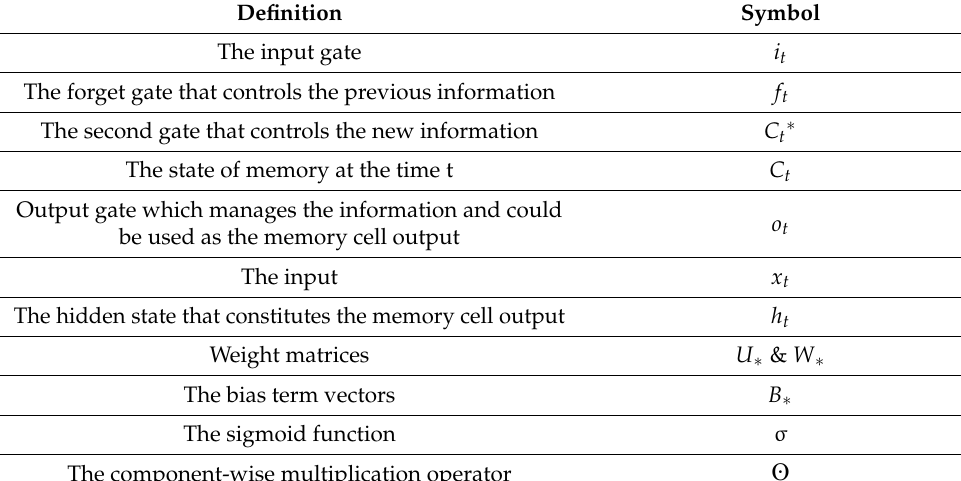
Table 1. LSTM Terms.